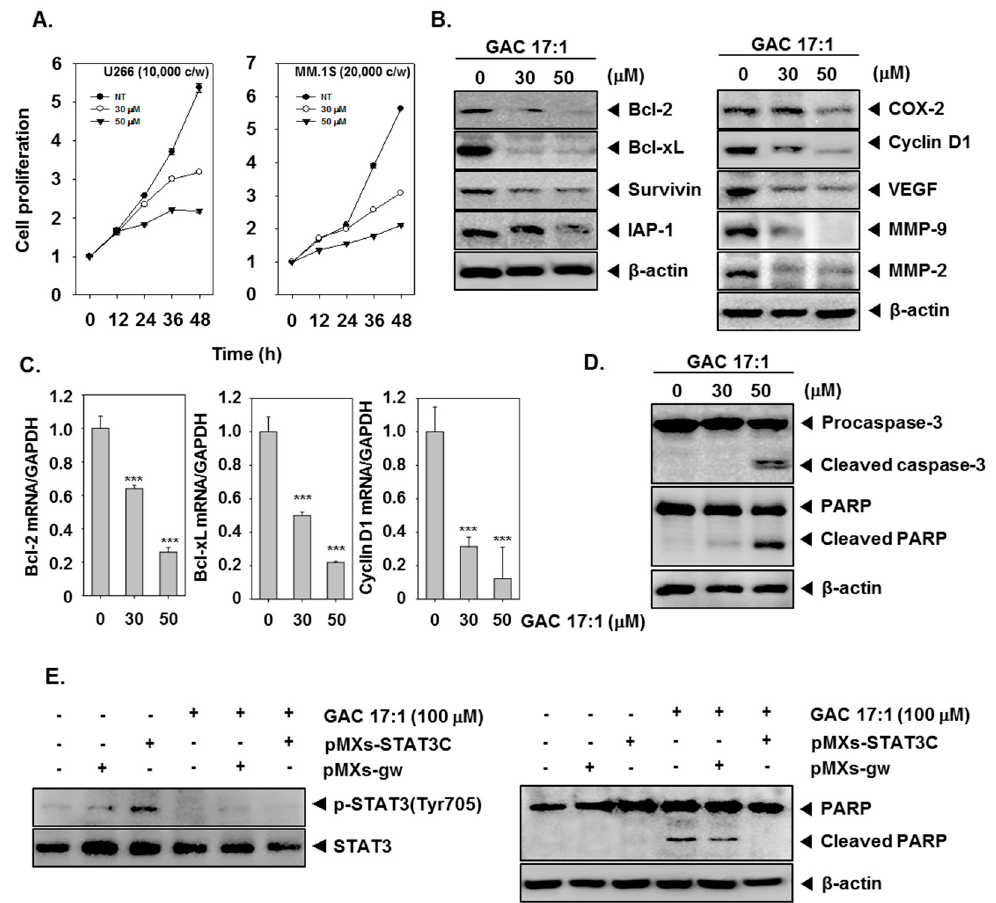
Figure 4. Suppression of STAT3 regulated gene products by GAC 17:1 in multiple myeloma cells. ( A ) U266 and MM.1S cells (1 or 2 × 10 4 cells/well) were incubated with the GAC 17:1 (30 or 50 μ M) for the indicated time intervals. MTT assay was performed to investigate the effect of GAC 17:1 on cell proliferation; ( B – D ) U266 cells (3 × 10 5 cells/well) were incubated with the GAC 17:1 (30 or 50 μ M) for 24 h. Lysates from the cells were analyzed using western blotting against Bcl-2, Bcl-xL, Survivin, IAP-1, COX-2, Cyclin D1, VEGF, MMP-9,MMP-2, Caspase-3, and PARP. In addition, Total RNA was isolated, and analyzed by real time PCR for Bcl-2, Bcl-xL, and Cyclin D1. Data represents means ± S.D., *** indicates p < 0.001; ( E ) MEF cells were transfected pMXs-STAT3C or pMXs-STAT3gw and incubated for 24 h. The cells were treated with GAC 17:1 (100 μ M) for 3 h (left panels) or 24 h (right panels). The lysates from the cells were analyzed by Western blotting using antibodies against p-STAT3 (Tyr705) and STAT3 (left panels) or PARP and β -actin (right panels) respectively.